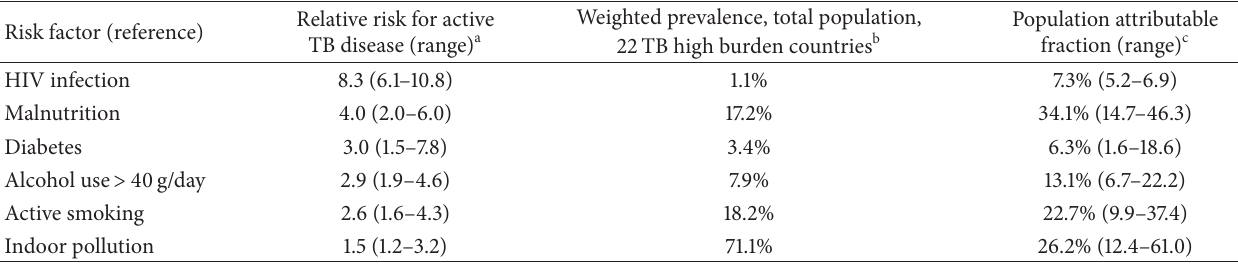
Table 1: Relative risk, prevalence and population attributable risk of selected risk factors for